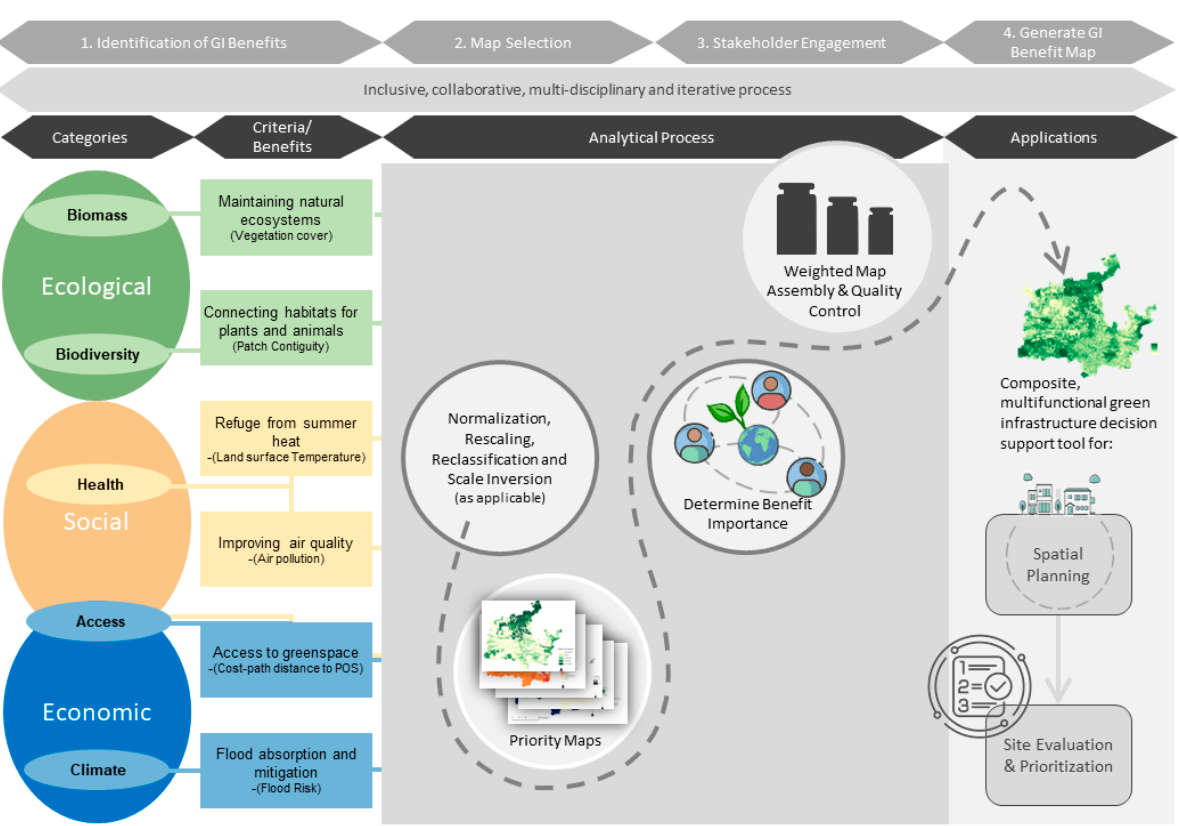
Figure 2. Conceptual figure showing the development process of the green infrastructure benefits decision support tool for the City of Tshwane, South Africa.